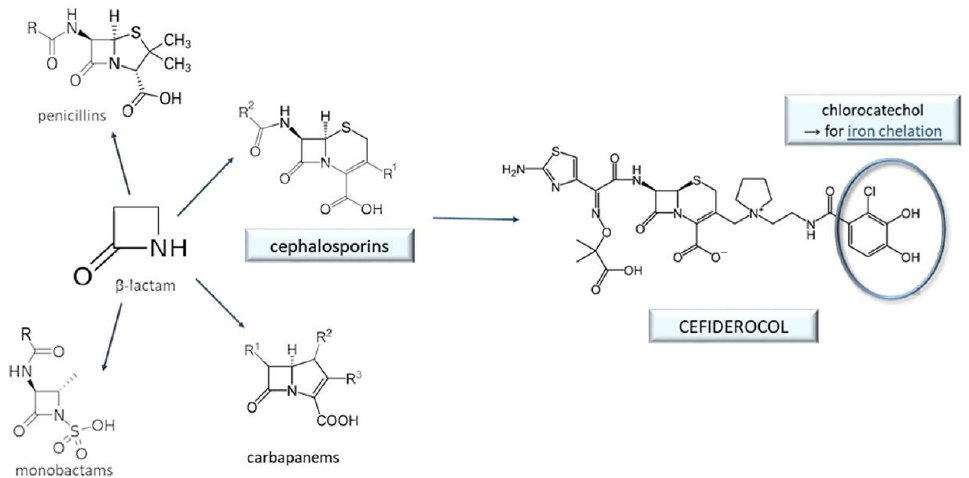
Figure 11. Classification of the β -lactam antibacterials. Cefiderocol, a member of the cephalosporin subgroup, contains a catechol moiety that enables it to chelate Fe 3+ ions and thus use the bacterial ferric ion transport system to enter the bacterial cell (the Trojan horse approach).